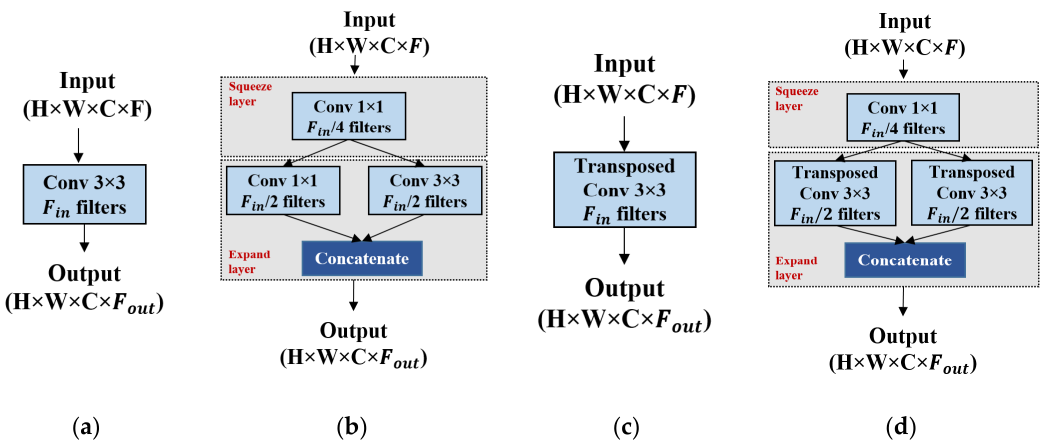
Figure 4. Schematic of fire module. ( a , c ) show the convolution for the encoder and decoder side in U-net [4] respectively; ( b , d ) show our corresponding squeeze U-SegNet at encoder and decoder side using squeeze and expand layers to reduce the number of parameters.